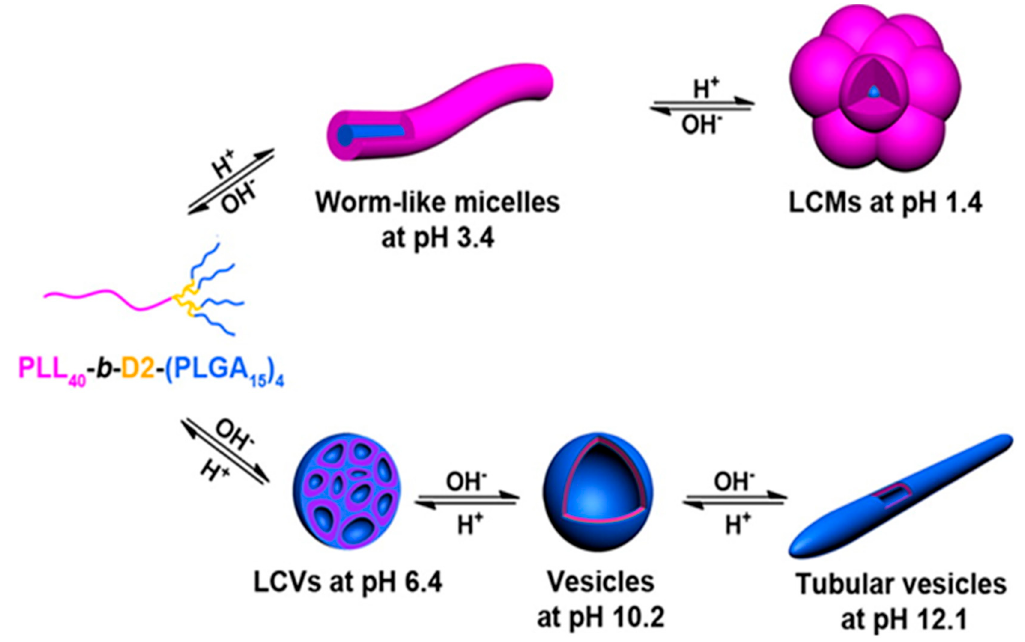
Figure 3. Schematic representation of pH-responsive self-assembly of linear-dendron-like polyampholyte, PLL- b -D 2 -(PLGA) 4 . Reproduced with permission from [55]. Copyright 2013, American Chemical Society.